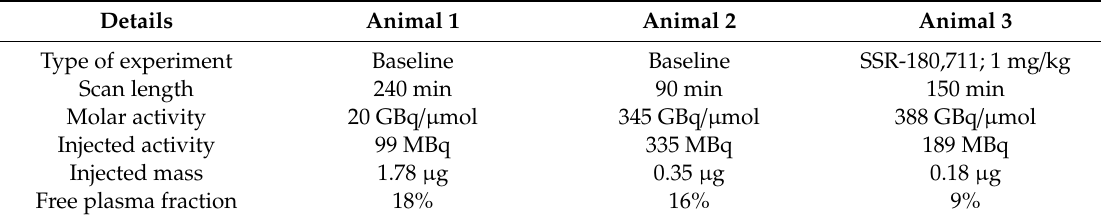
Table 4. Experimental details of [ 18 F]ASEM PET scans in